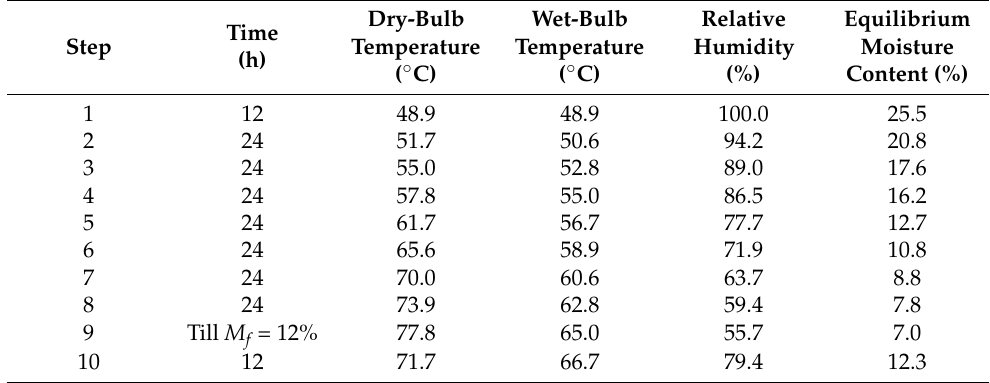
Table 2. Control (unmodified) drying schedule used in industrial kilns in British Columbia sawmills. This schedule comprises eight time-based steps, one moisture-based step, and one conditioning step.